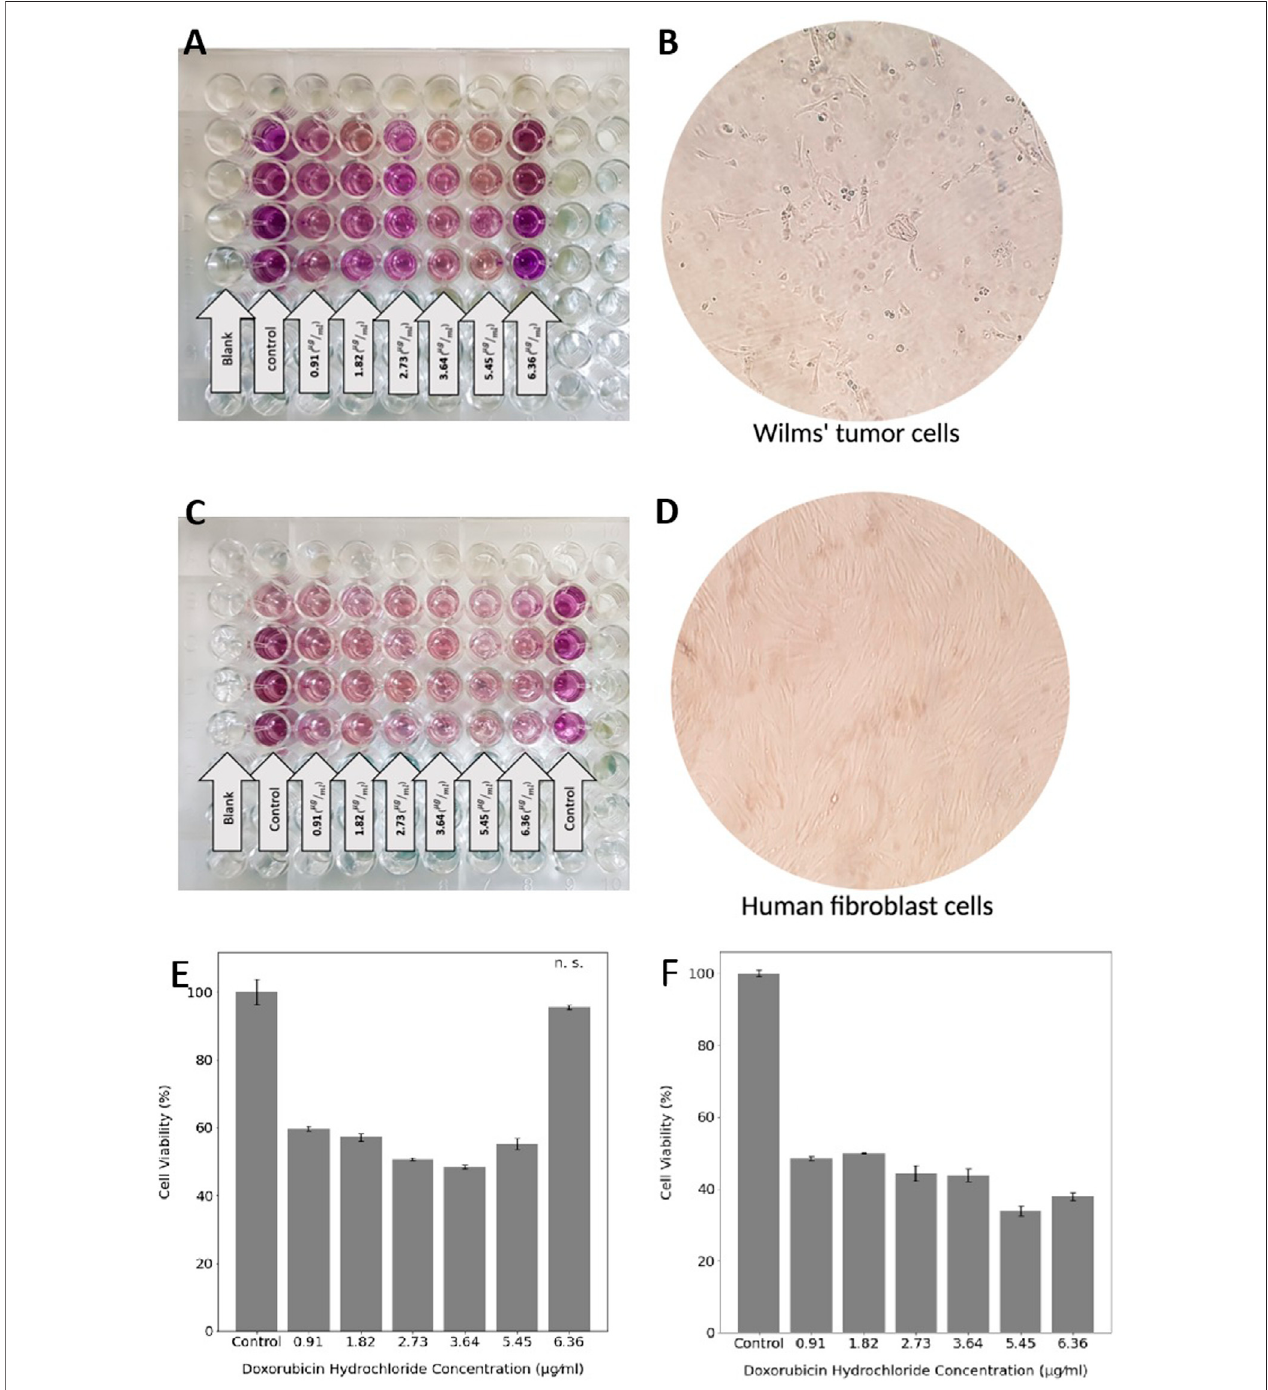
FIGURE 5 | MTT assay of Wilms ’ tumor and (A) and human fi broblast cells (C) . The morphology of Wilms ’ tumor (B) and human fi broblast (D) cells under the microscope.CellviabilityofWilms ’ tumor (E) andhuman fi broblast (F) intheexposureofsixdifferentDOXconcentrations.Statisticaldifferencesbetweenthecontroland other groups were determined with ANOVA, mean ± SD; n = 4, p < 0.05, n. s. = not signi fi cant.